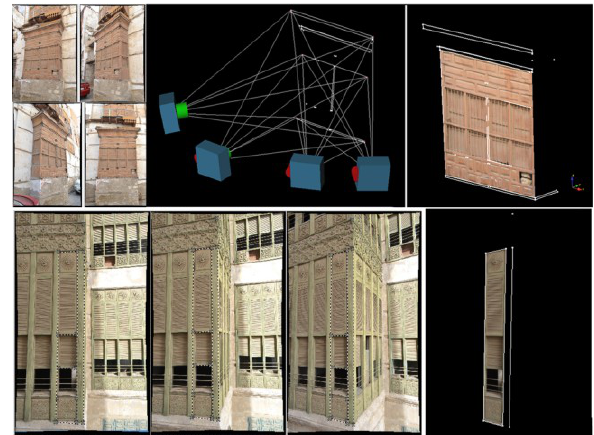
Figure 5. Extraction process of points and edges in PMS © .